Question: What type of chart is this?
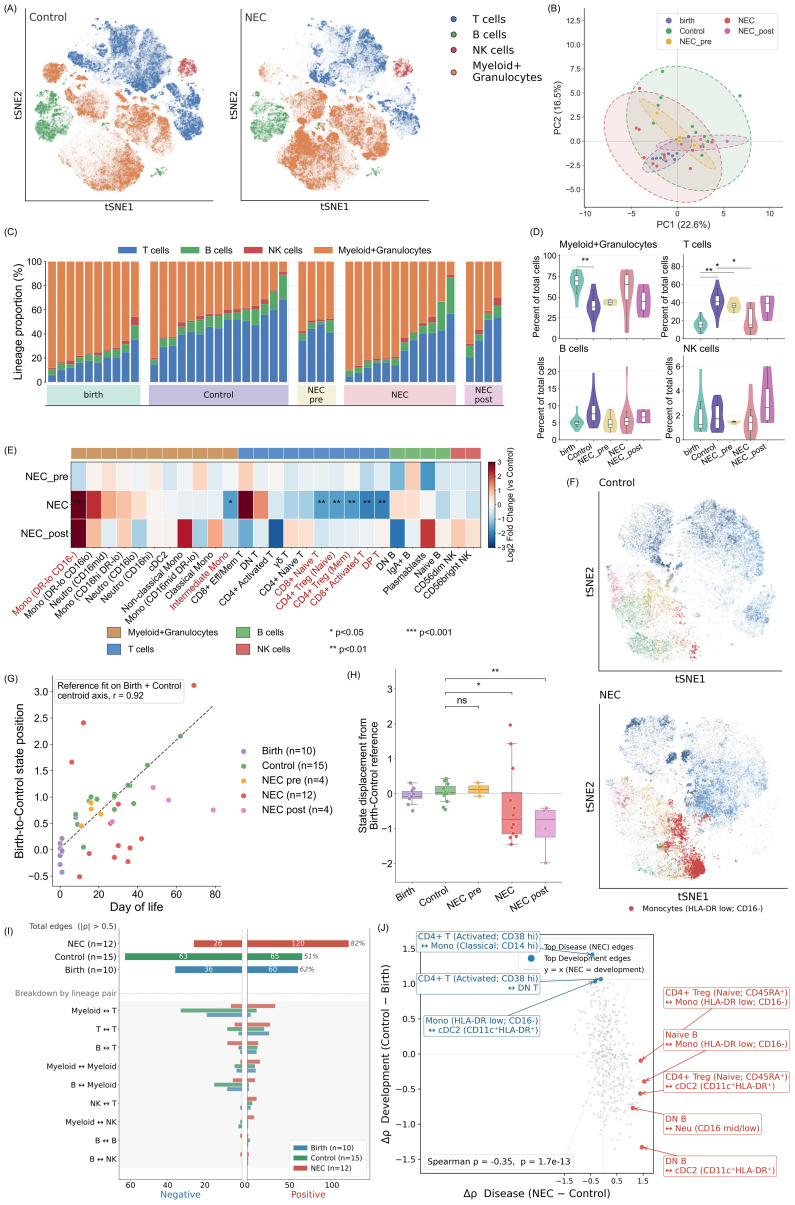
Answer: heatmap